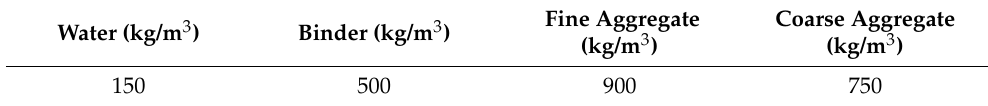
Table 3. Assumed mix design for generalization